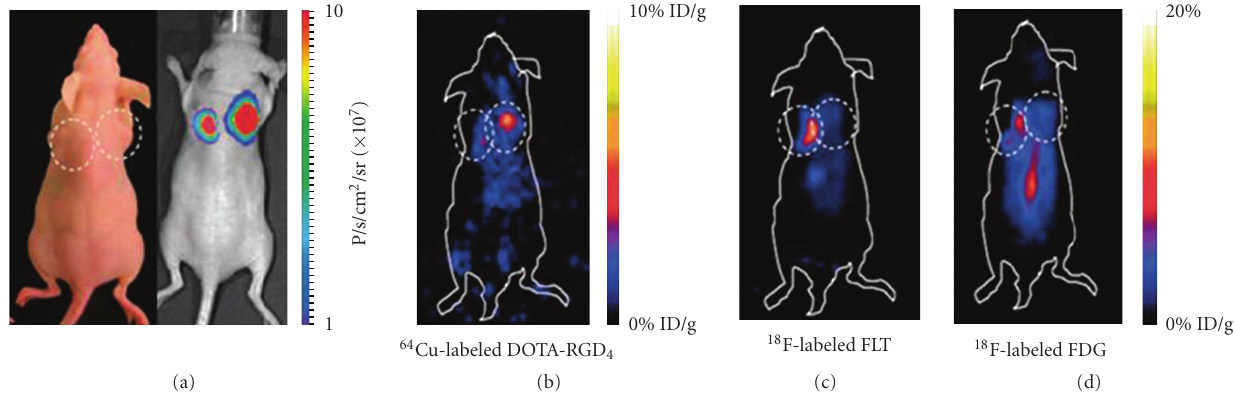
Figure 3: Micro-PET imaging of 18 F-FDG, 18 F-FLT, and 64 Cu-DOTA-RGD4 on hES cell-derived teratoma. (a) Background imaging and bioluminescence imaging show teratoma formation in H9Hes-DF cells in the right shoulder and tumor formation in the control 2008 cell line in the left shoulder (7 . 3 ± 2 . 5 × 10 7 versus 4 . 5 ± 1 . 6 × 10 7 photon/s/cm 2 /sr, resp.); (b) specific and prominent uptake of 64 Cu-DOTA- RGD4 was found in the vascularized teratoma but not in the control human ovarian carcinoma 2008 cell line with low integrin expression ( P < 0 . 01); (c) hES cell-derived teratomas had a low uptake of 18 F-FLT, whereas the 2008 cancer xenografts exhibited high 18 F-FDG and 18 F-FLT uptakes; (d) hES cell-derived teratomas had a low uptake of 18 F-FDG, whereas the 2008 cancer xenografts and abdomen exhibited